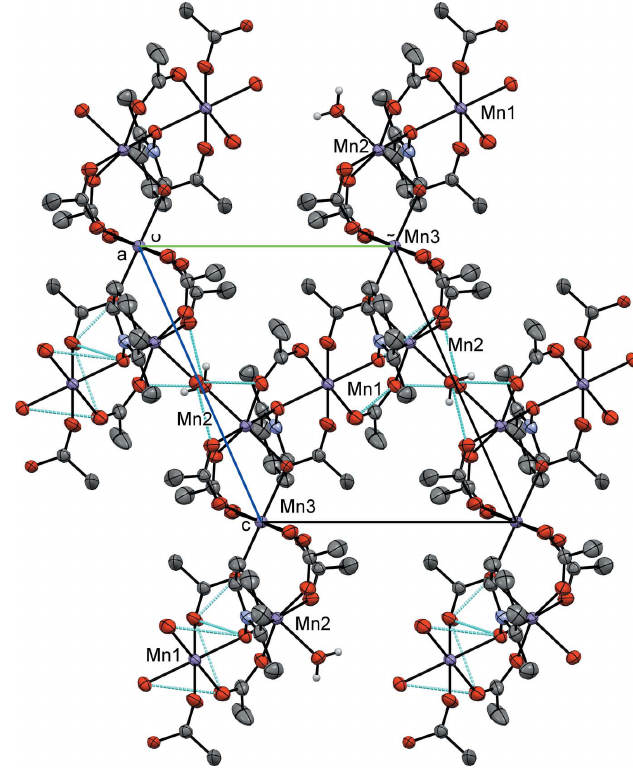
Figure 5 Crystal packing diagram of compound II , viewed along the a axis. H atoms not involved in hydrogen bonding have been omitted for clarity, hydrogen bonds are rendered in